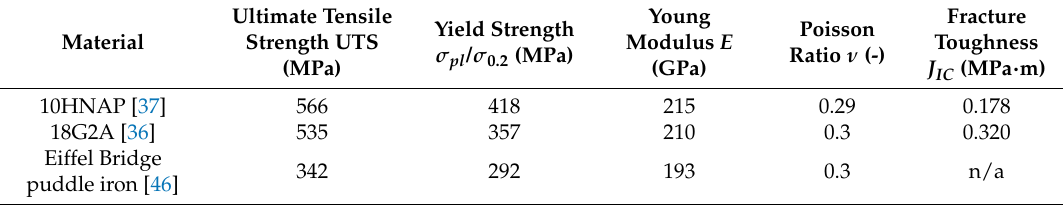
Table 3. Low cycle fatigue properties of the analyzed materials.